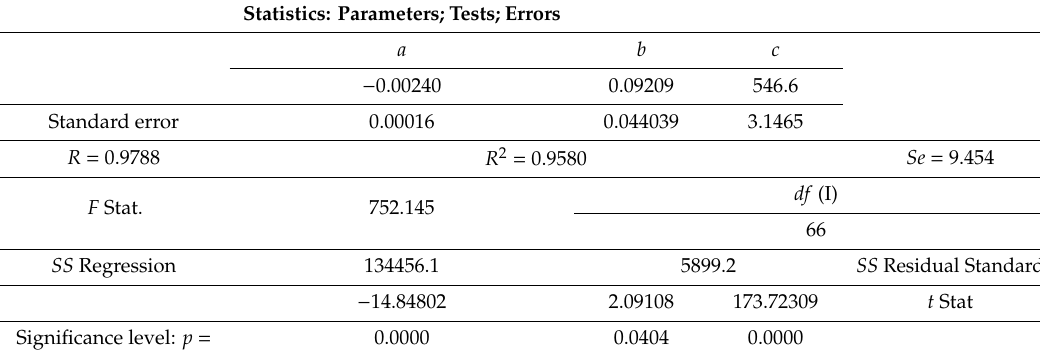
Table 3. The statistical significance for the model: y = − 0.0024 x 2 + 0.0921 x +